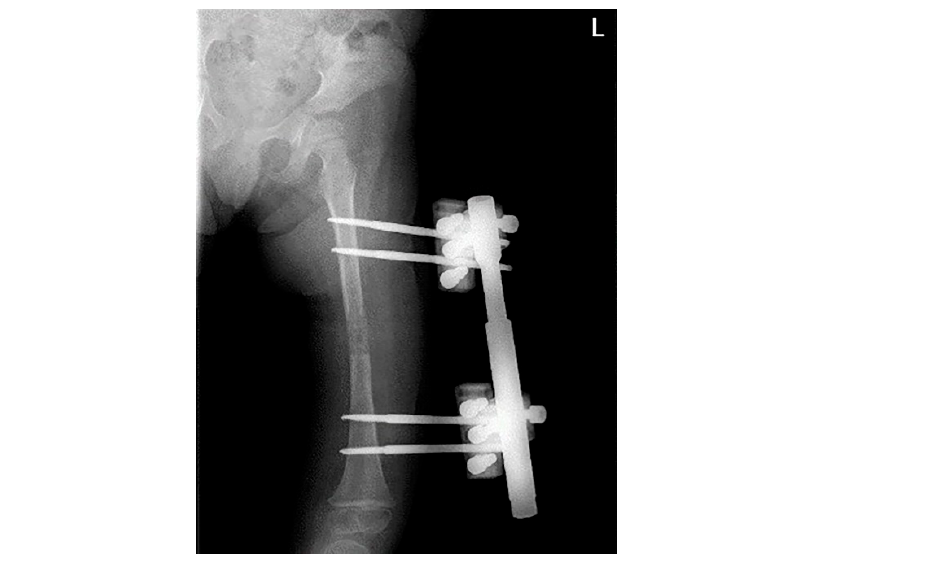
Figure 4. Completion of lengthening at 79 days with good callus formation (L = Left).